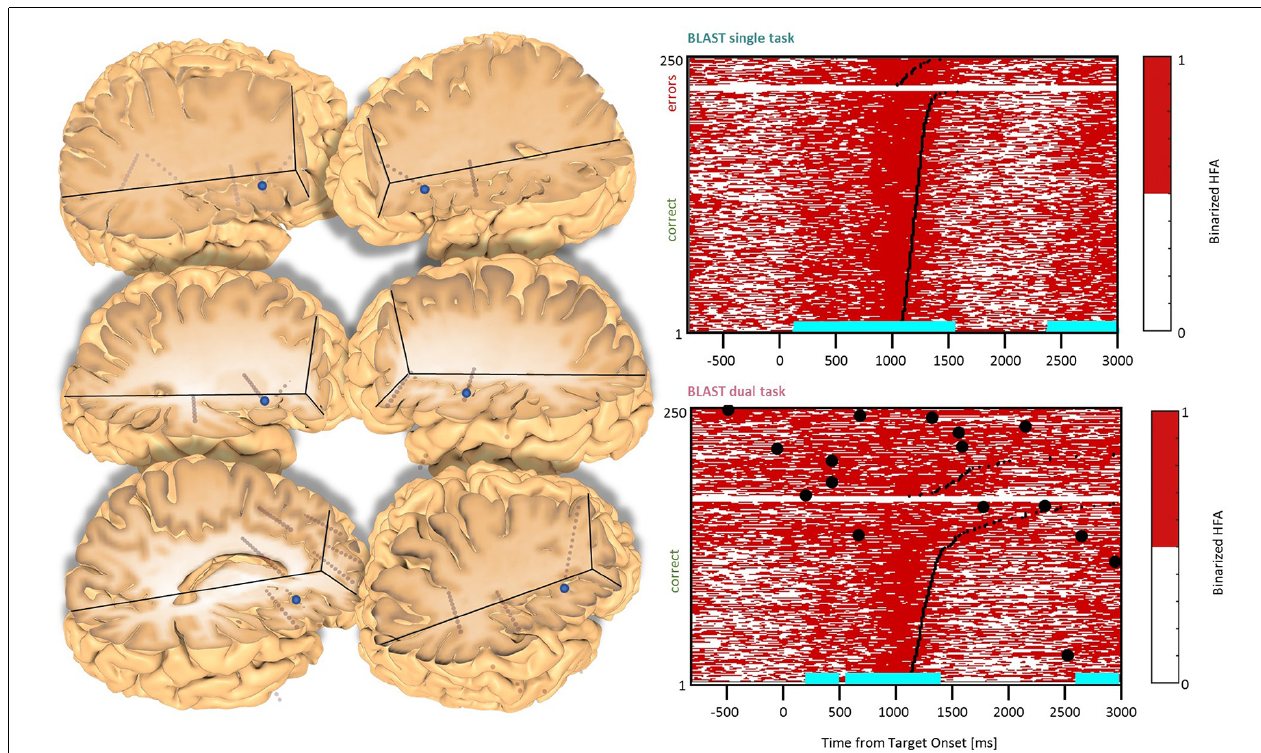
FIGURE 6 | Interference in the Anterior Insula. Sites with interference between T1 and T2 are displayed at their precise anatomical location onto a 3D representation of the participant’s brain. The matrix representation reproduces the display of Figure 2 , for the single-task and dual-task conditions for one of the sites. Patients id [Px] and iEEG site names, from left to right and top to bottom: X7 [P3]; X’9 [P3]; X5 [P11]; X’9 [P11] (matrix displayed) ; E4 [P7]; X7